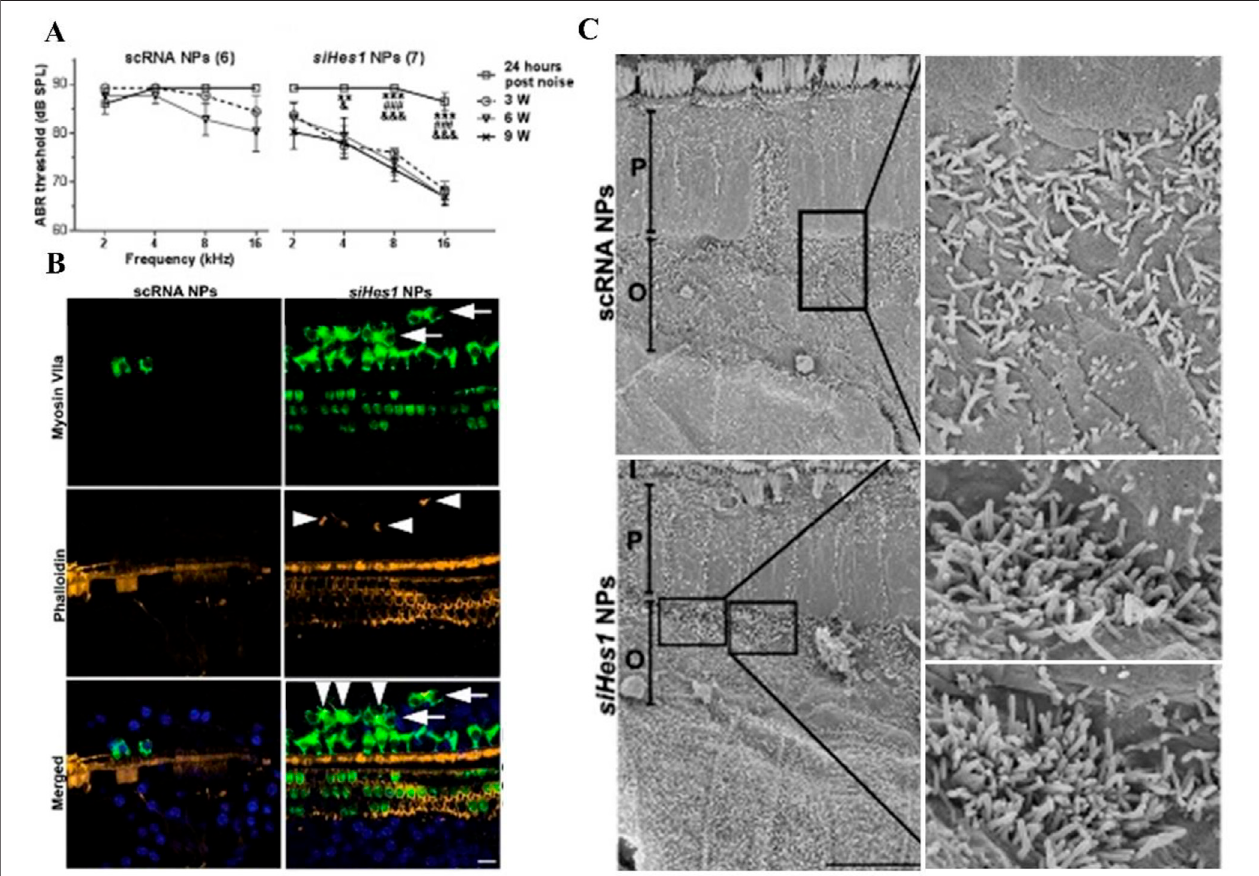
FIGURE 5| Hair cell restoration and functionalrecovery were observed only in noise-deafened ears treated with siHes1 encapsulated polylactic/glycolic acid NPs. (A) In comparison to pre-treatment ABR thresholds, no signi fi cant hearing improvement was observed in noise-deafened guinea pigs treated with scRNA NPs at any timepointaftertreatment.Whilesigni fi canthearingimprovementwasobservedatalltimepoints(3,6,and9weeksaftertreatment)insiHes1-NP-treatedearsacrossthe 4-to16-kHzfrequencyrange. (B) Green,HCs;yellow,stereocilia;blue,4 ′ ,6-diamidino-2-phenylindole(DAPI)fornuclei.SupernumeraryIHCs(arrowheadsingreen with anti-myosin VIIa) were only observed in siHes1 NP-treated cochleae. (C) Clusters of immature HCs with dense and short stereocilia were observed by scanning electronmicroscopyinnoise-deafenedcochleaeaftersiHes1NPtreatment.Suchcellswerenotobservedinnoise-deafenedcochleaetreatedwithscRNANPs.I,P,and O indicate IHCs, pillar cells, and OHCs,